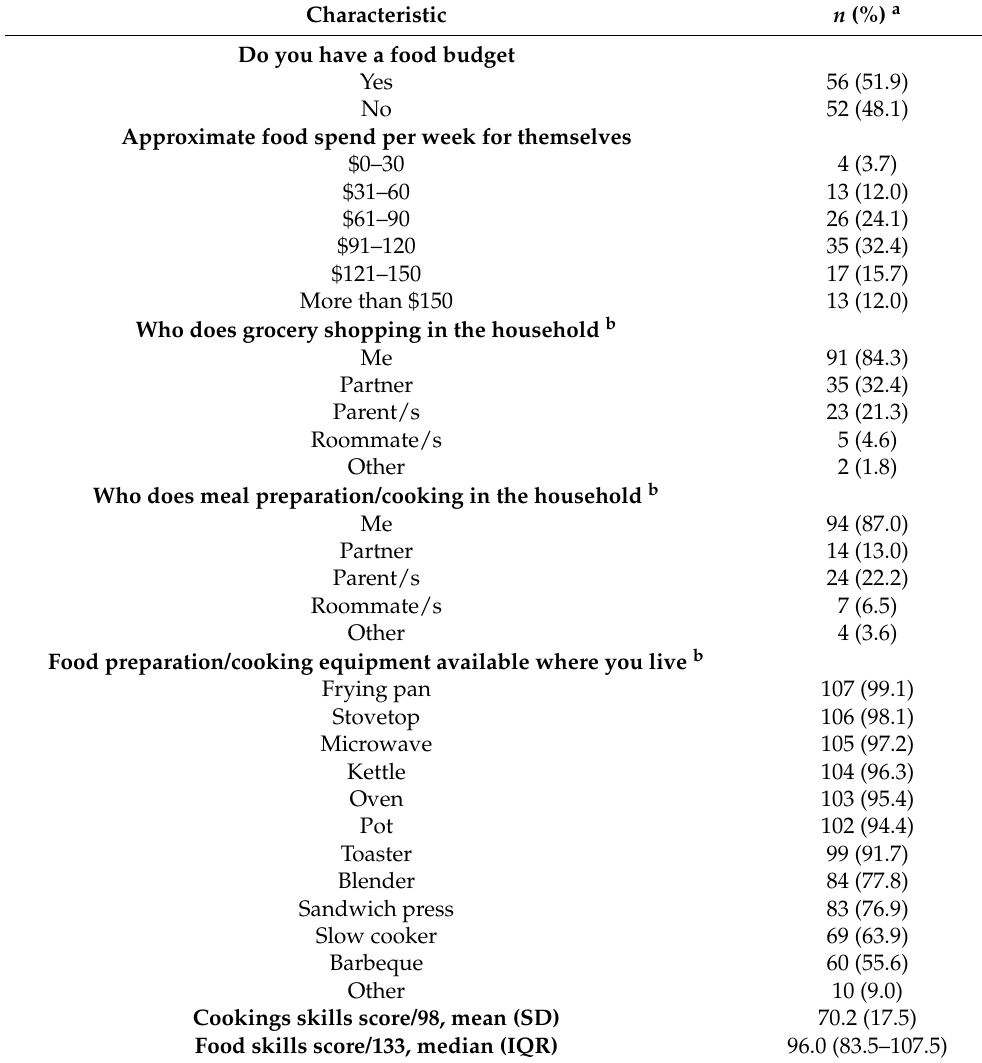
Table 2. Cooking and food related characteristics of young adults with low diet quality who use the ‘No Money No Time’ website ( n =